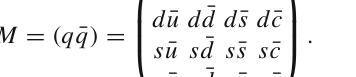
Fig. 2 Hadronization process for ψ( 4040 ) [ ψ( 4160 ) ] → ii